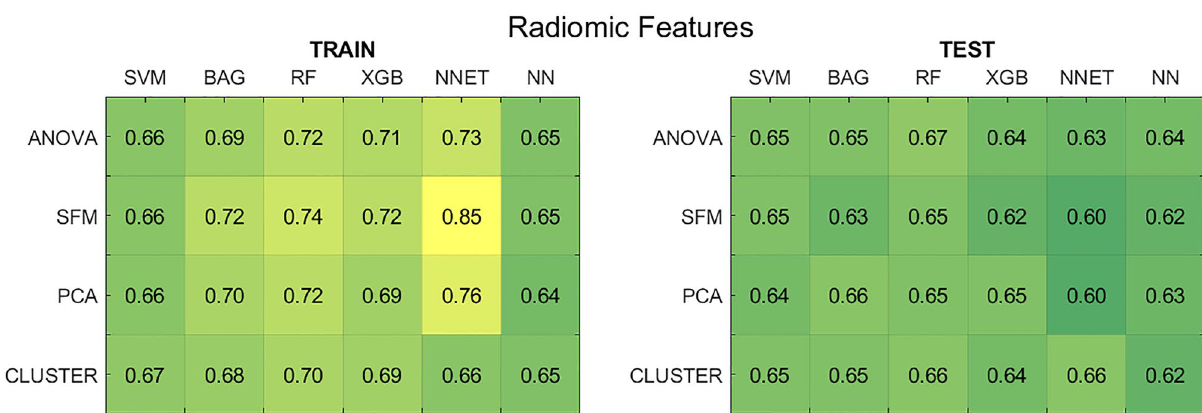
Figure 4. Results for the radiomic feature-based models without the use of clinical data. (Left panel) Average AUCs on the five training splits. (Right panel) Average AUCs on the test splits. SFM SelectFromModel, PCA principal component analysis, CLUSTER feature agglomeration through clustering, SVM support vector machines, BAG bagging, RF random forest, XGB extreme gradient boosting, NNET neural network, NN k-nearest